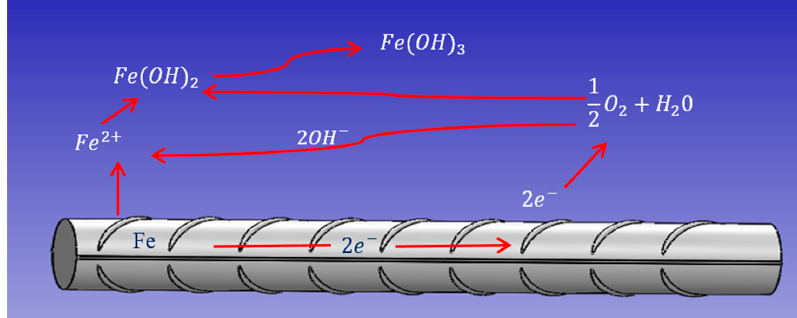
Figure 4. Chemical process of accelerated steel bar corrosion.